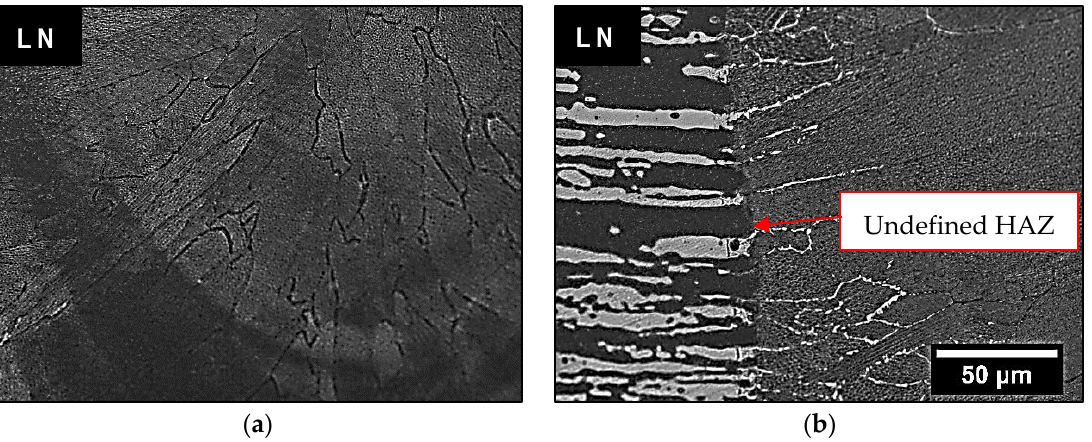
Figure 9. OM of LN weld bead where (a) the γ is imperceptible and (b) there is an undefined HAZ.